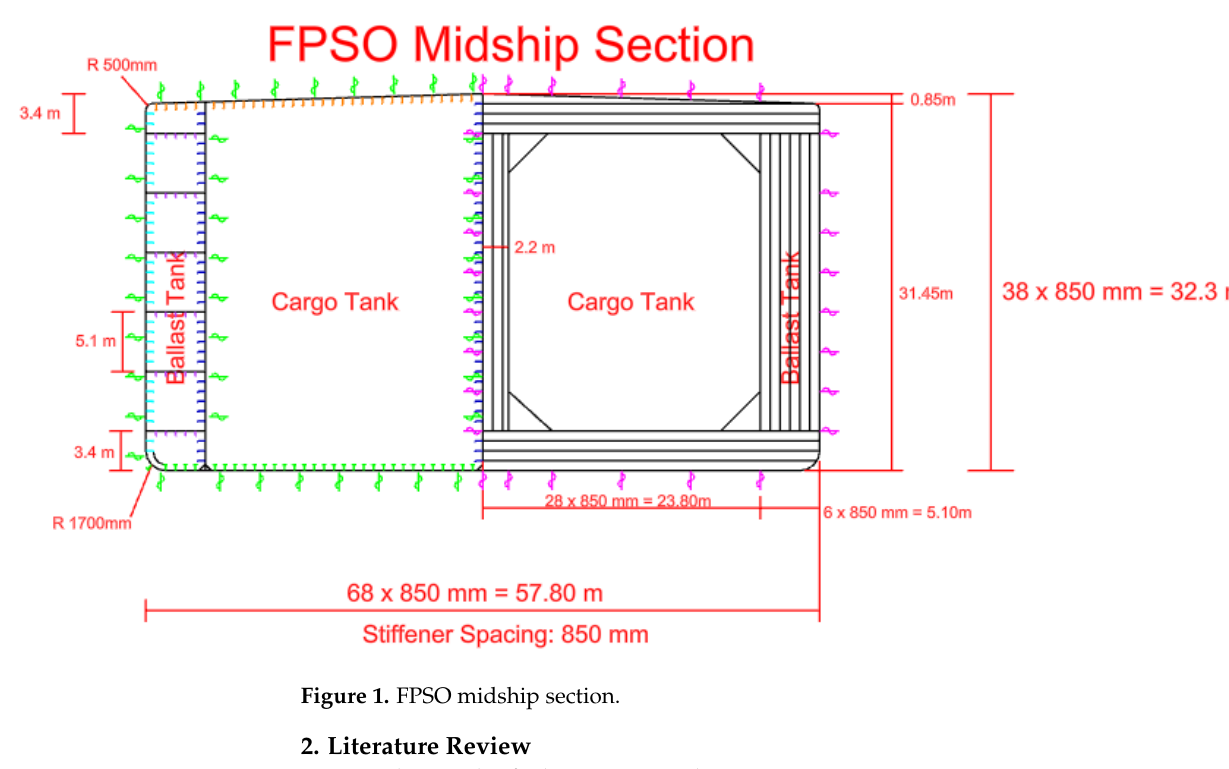
Figure 1. FPSO midship section.